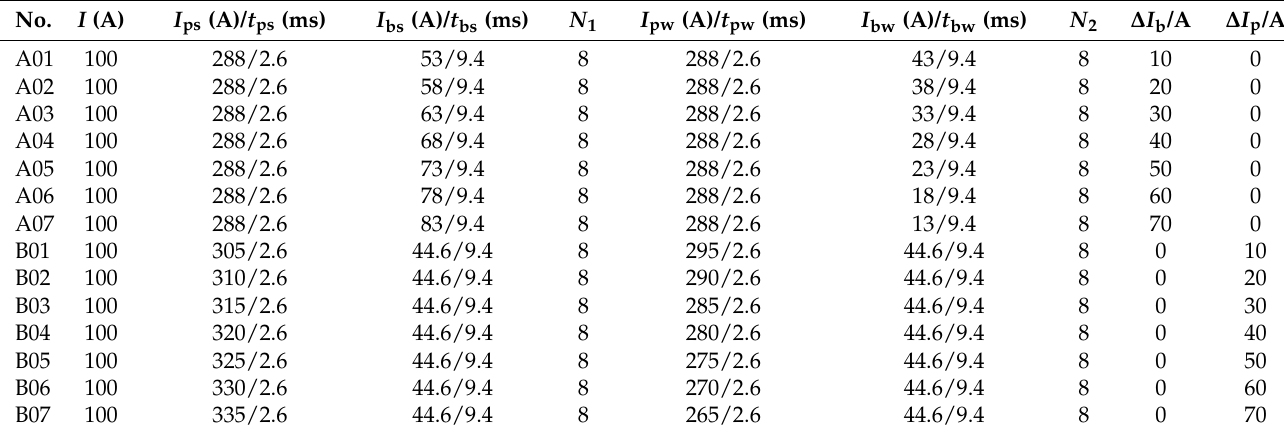
Table 2. Welding parameters of